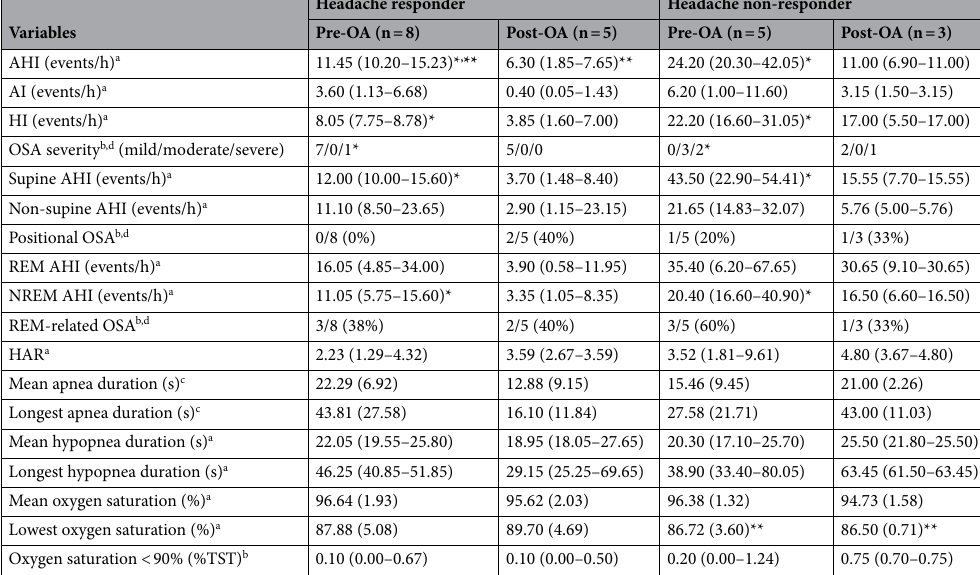
Table 3. Polysomnographic characteristics according to headache responder group-respiratory parameters. OA oral appliance, AHI apnea hypopnea index, AI apnea index, HI hypopnea index, REM rapid eye movement sleep, NREM non rapid eye movement sleep, HAR hypopnea/apnea ratio, RAR respiratory effort related arousal index + hypopnea/apnea ratio. *Significant difference: P < 0.05, comparison between headache responder and non-responder. **Significant difference: P < 0.05, comparison between pre- and post-oral appliance treatment. a Differences between groups were tested with Mann–Whitney test and pre- and post-OA data were tested with Wilcoxon Rank-sum test: Median (lower quartile-upper quartile). b Differences between groups were tested with Chi-square test and pre- and post-OA data were tested with McNemar’s test. c Differences between groups were tested with t-test and pre- and post-OA data were tested with paired t-test: Mean (SD). d Results given as number of patients with mild, moderate, severe, positional, REM-related OSA/total number of patients (percentage of patients with each